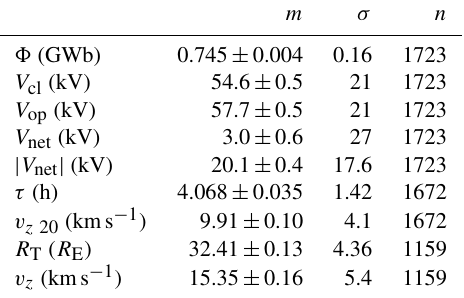
Table 1. Statistical characteristics of the estimated open mag- netic flux ( (cid:56)) , absolute value of the magnetic flux closure volt- age ( V cl ) , magnetic flux opening voltage ( V op ) , net reconnection voltage ( V net ) and its absolute value ( | V net | ), residence timescale of the open magnetic flux ( τ) , cross-tail plasma velocity estimated assuming a 20 R E tail radius ( v z 20 ) , tail radius estimated from the ACE solar wind data using the model of Petrinec and Russel (1993, 1996) ( R T ) , and cross-tail plasma velocity estimated assuming the tail radius is that estimated using the model of Petrinec and Rus- sel (1993, 1996) ( v z ) . The estimated averages and standard devia- tions are given with the number of SI12 images used in the statistics. m σ n (cid:56) (GWb) 0.745 ±